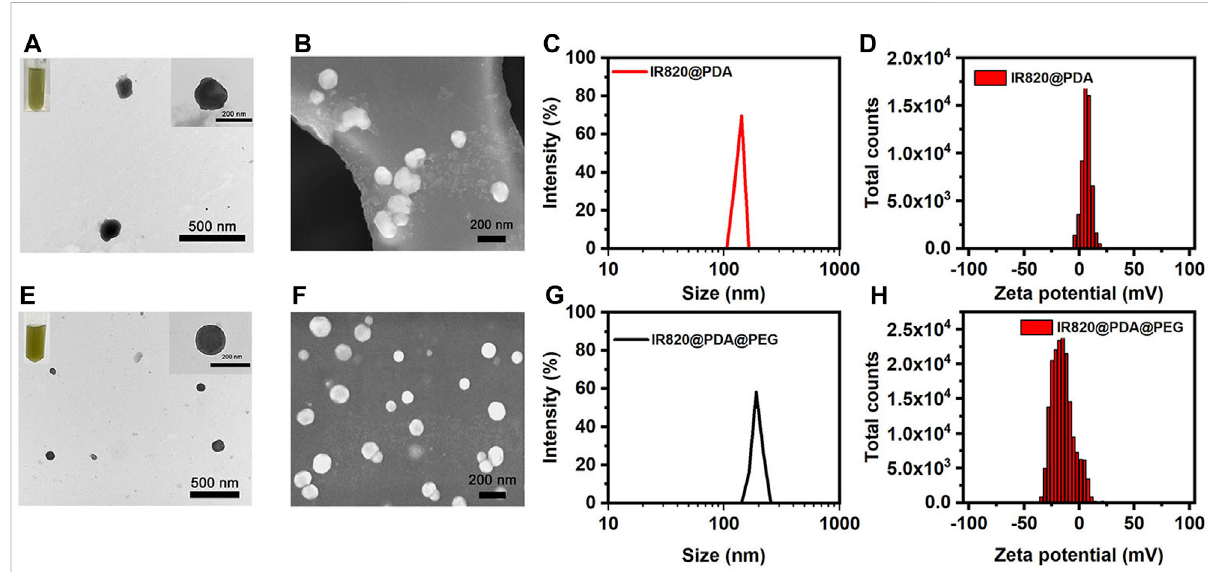
FIGURE 1 Characterization of IR820@PDA NPsand IR820@PDA@PEG NPs. (A) TEM(scale bar = 500 nm). (B) SEM (scale bar = 200 nm). (C) DLS result. (D) Zeta potential of IR820@PDA NPs. (E) TEM (scale bar = 500 nm). (F) SEM (scale bar = 200 nm). (G) DLS result. (H) Zeta potential of IR820@PDA@ PEG